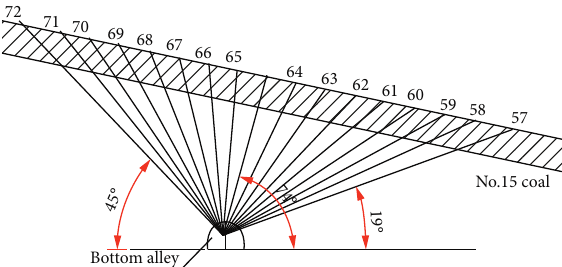
Figure 9: Sectional view of blast observation hole number.